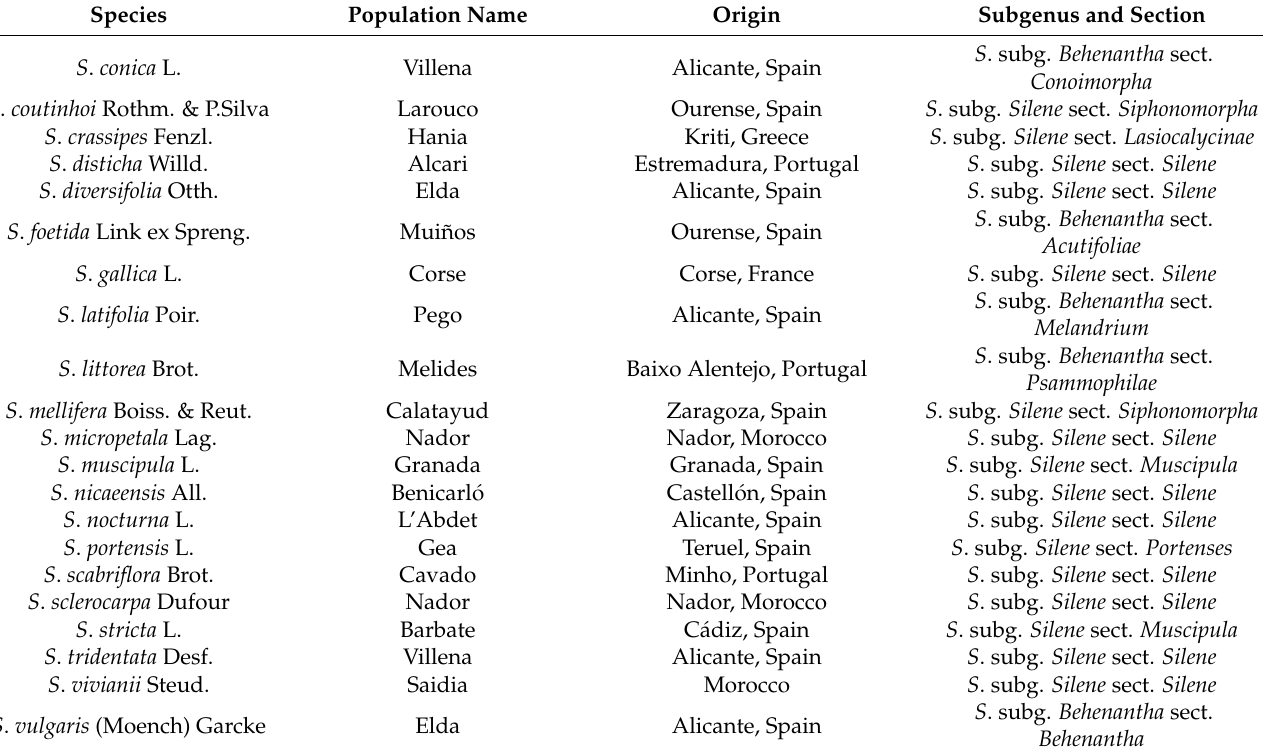
Table 1. A summary of the species of Silene analyzed in this